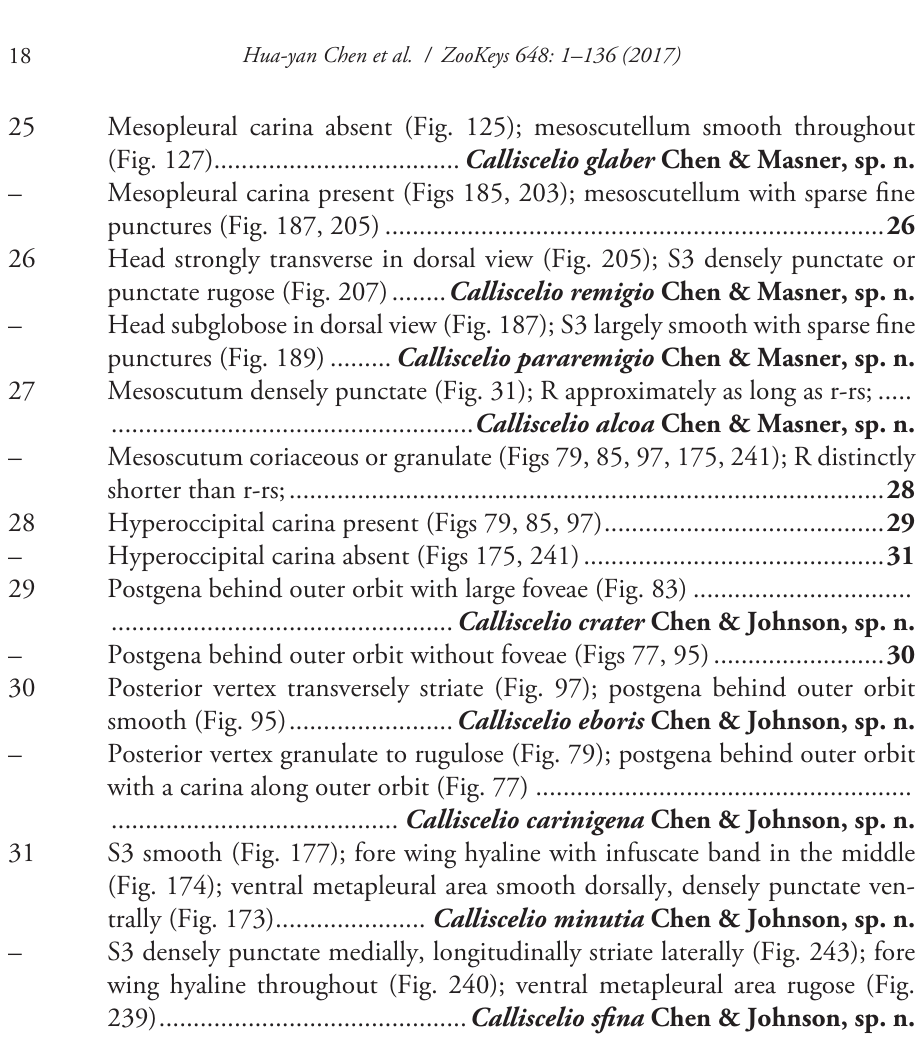
clava (A7–A12): dark brown to black. Shape of head: subglobose. Central keel of frons: absent. Setation of upper frons: with sparse, long setae. IOS/EH: IOS distinctly less than EH. Sculpture of ventrolateral frons: smooth to coriaceous. Sculpture of frons below median ocellus: coriaceous. Sculpture of posterior vertex: granulate to rugulose. Hyperoccipital carina: absent. Occipital carina medially: complete, weakly crenulate throughout. Length of OOL: less than 0.5× ocellar diameter. Sculpture of